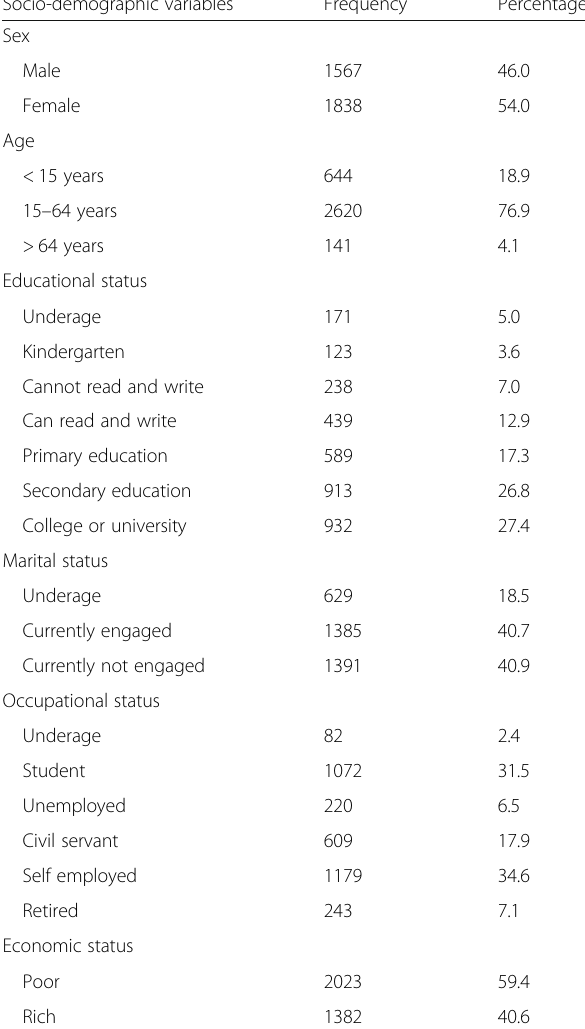
Gondar town, northwest Ethiopia, March – April 2017 Socio-demographic